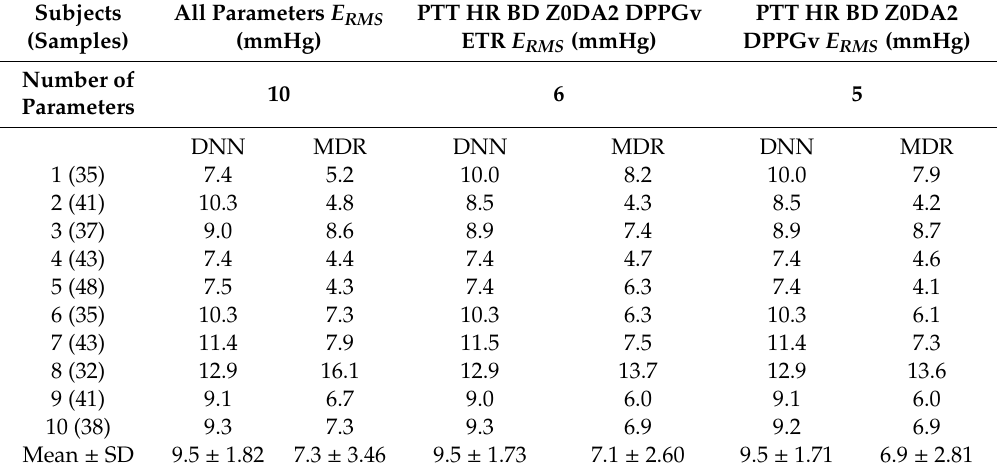
Table 5. The E RMS statistics (mean ± SD) of the estimated systolic pressure for the ten subjects using the parameters of pulse wave and PTT.